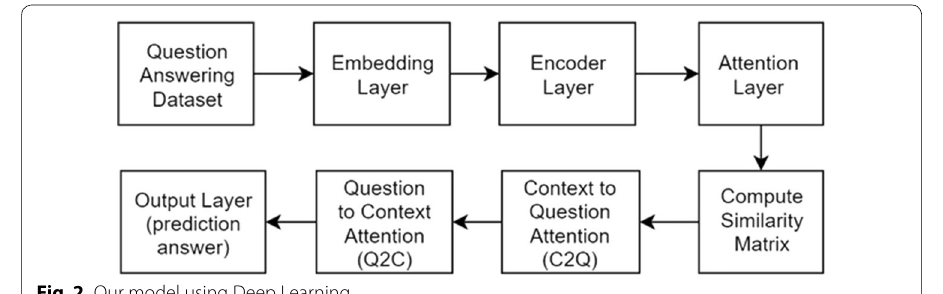
Fig. 2 Our model using Deep